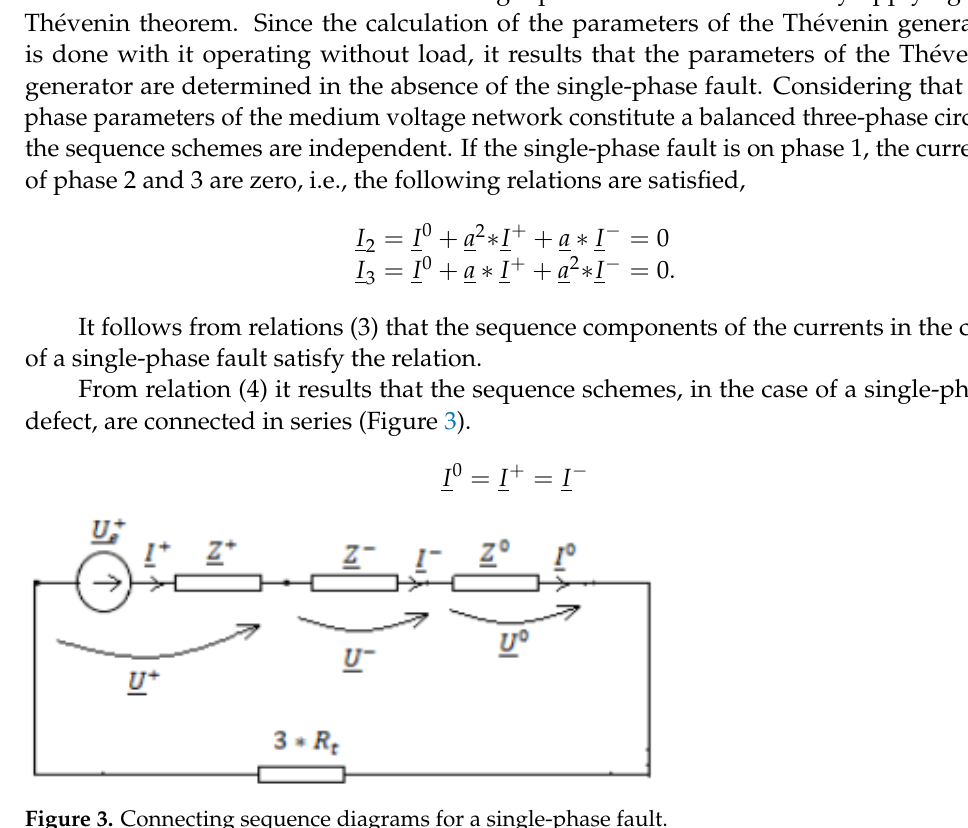
Figure 3. Connecting sequence diagrams for a single-phase fault.